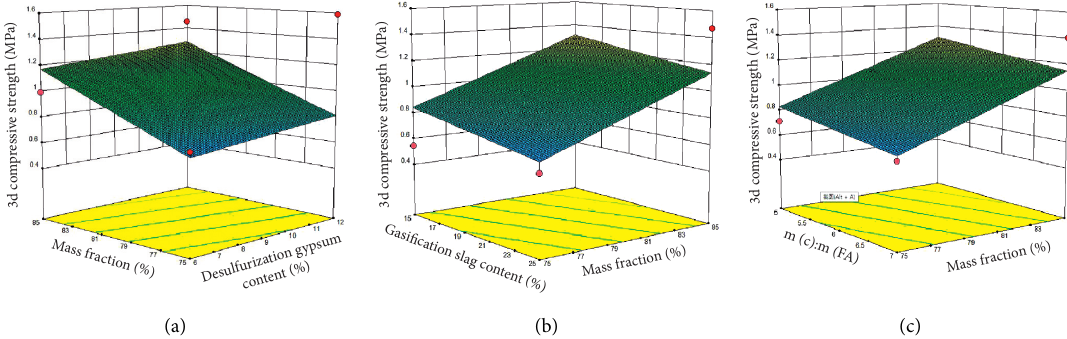
Figure 11: Analysis of interaction factors of 3d uniaxial compressive strength response surface. (a) X interaction cloud. (c) X 2 X 3 interaction